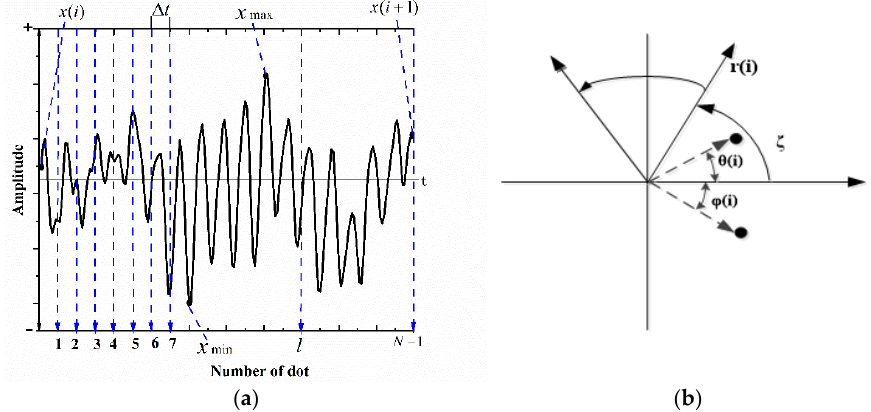
Figure 1. SDP schematic diagram. ( a ) Original signal. ( b ) SDP image conversion.